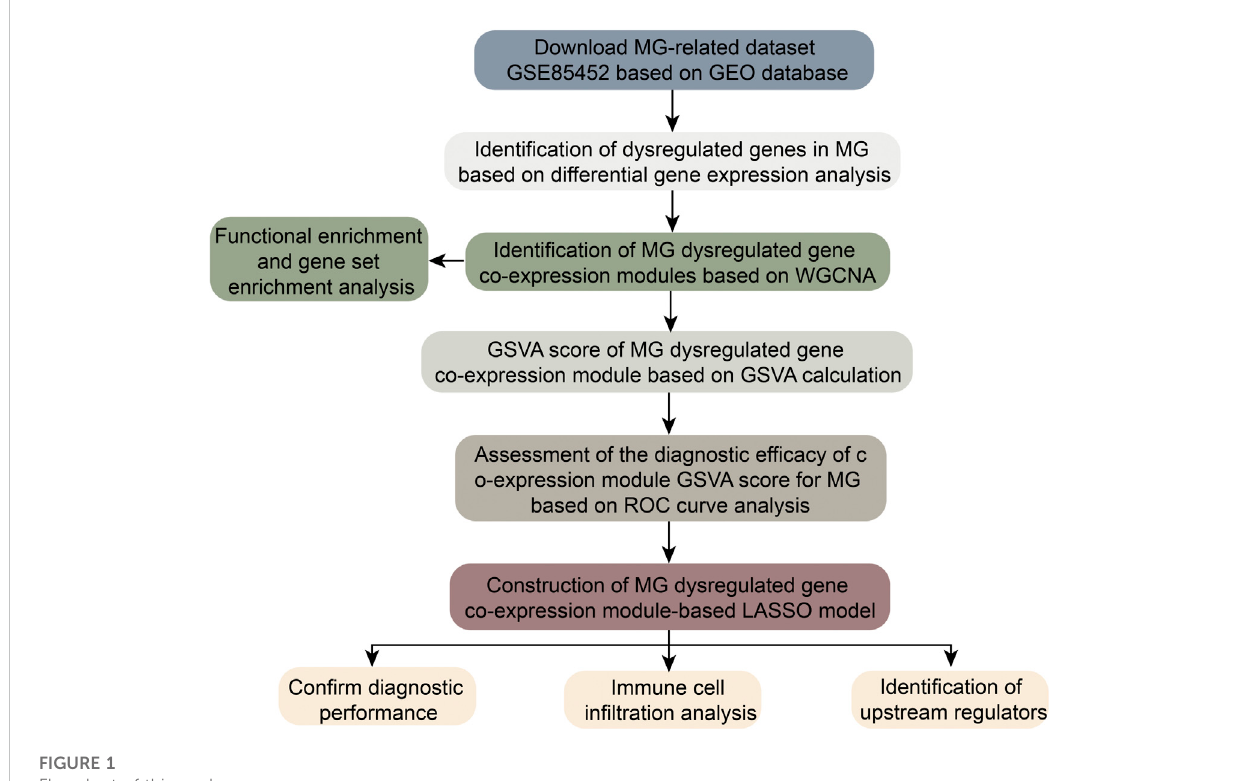
FIGURE 1 Flowchart of this